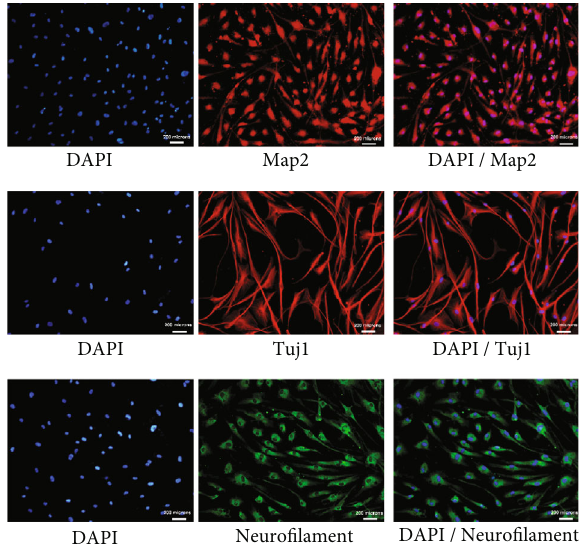
Figure 8: Protein expression in neuronal-like cells. Representative immuno fl uorescence images of WJ-MSCs derived neuronal-like cells stained with respective antibodies ( mean ± SEM , n = 3